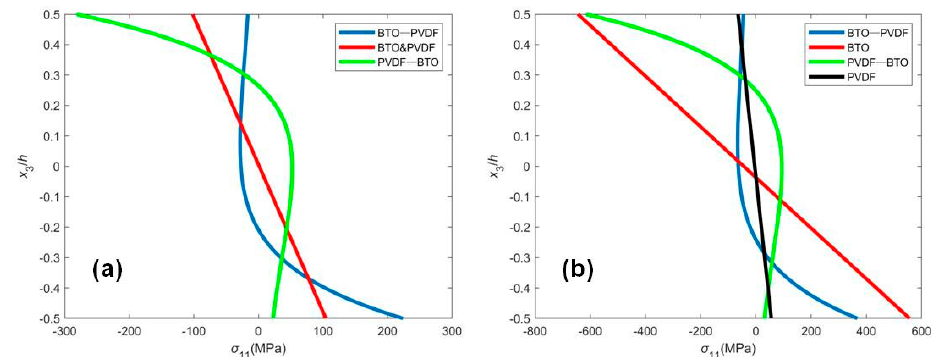
Figure 3. The stress distribution σ 11 of the FGM piezoelectric cantilever nanobeam subjected to ( a ) mechanical loading q = 0.01 nN / nm , V 0 = 0 and ( b ) electrical loading V 0 = − 1 V , q = 0.